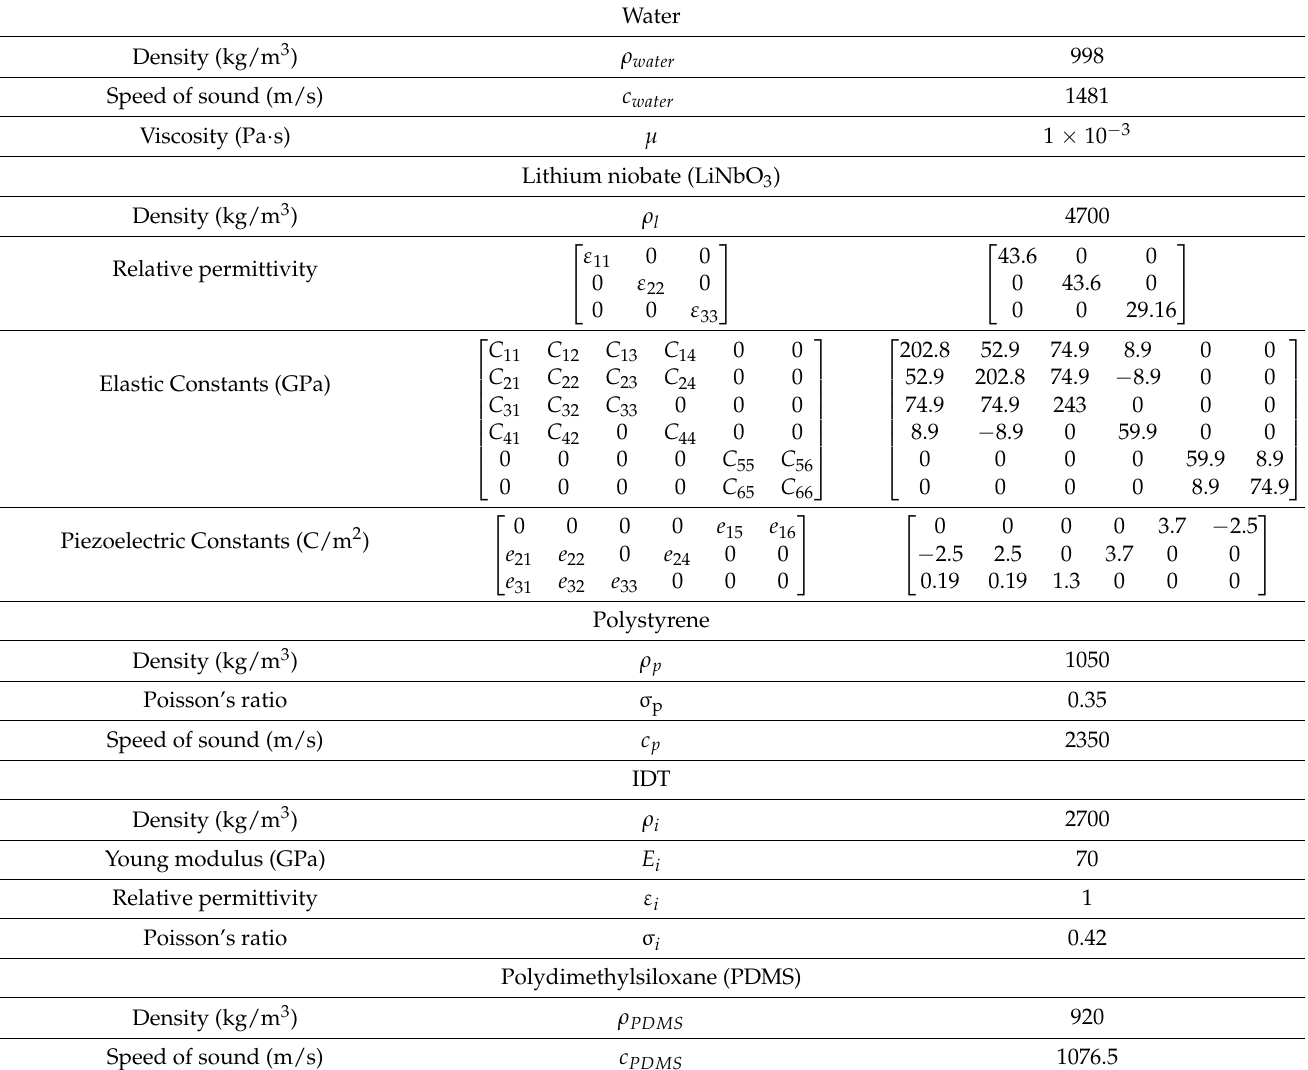
Table 2. Material